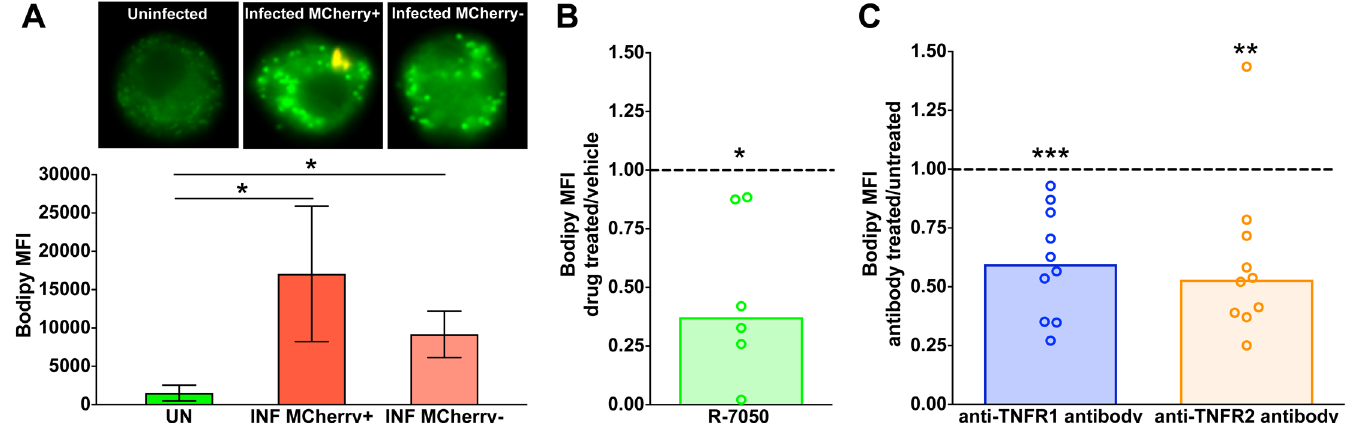
Fig 4. Role of TNFR in lipid droplet formation in M . tuberculosis- infectedmacrophages. MDM were infected with mCherry-expressing M . tuberculosis and treated either with R-7050 (TNFR chemical inhibitor) or DMSO (vehicle control). When TNFR neutralizing antibodies were used, MDM were either pre-treated with the antibodies or left untreated, and then infected. Uninfected samples were included as controls. Lipid droplet content was measured as described in Fig 3. ( A ) Representative images of uninfected and infected macrophages obtained by imaging flow cytometry (60 × magnification) and lipid droplet content determination; lipid droplets are fluorescent green signals and bacteria are orange signals. Each bar of the graph represents the average and standard deviation of median Bodipy fluorescence intensity per cell obtained from three donors. Effect of R-7050 ( B ) or TNFR neutralizing antibodies ( C ) on lipid droplet content of infected macrophages. Results are expressed as the ratio between lipid droplet content of treated and untreated cells. Graphs show the median of six ( B ) and ten ( C ) donors (each dot represents one donor). Statistical significance ( (cid:3) p < 0.05, (cid:3)(cid:3) p < 0.01, (cid:3)(cid:3)(cid:3) p < 0.001) was assessed by paired (panel A ) and one-sample (panels B and C ) student t-tests. The comparisons in the paired tests are as indicated; the comparison in the one-sample student t-test was between treated and untreated cells. UN: uninfected, INF: infected, TNFR1 AB: TNFR1 neutralizing antibodies, TNFR2 AB: TNFR2 neutralizing antibodies.